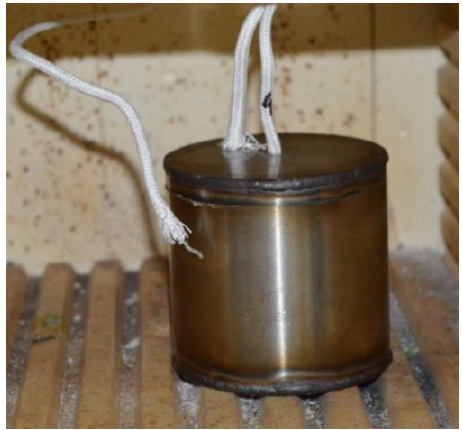
Figure 3. Assembly of the device with